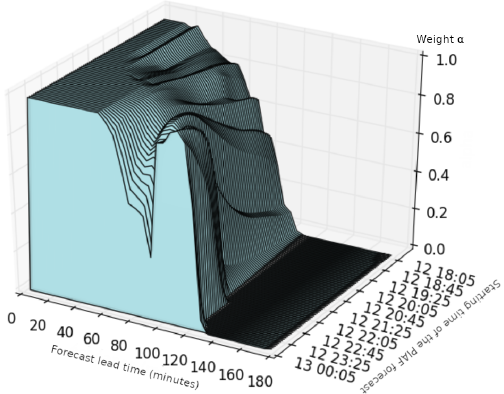
Figure 2. 3-D representation of the weight α given to radar ex- trapolation in PIAF. It shows the PIAF forecast lead time (interval [0, 180min]) dependency on α (interval [0, 1]) for PIAF forecasts starting from 12 October 2016 18:05 coordinated universal time (UTC) to 13 October 2016 00:05UTC.